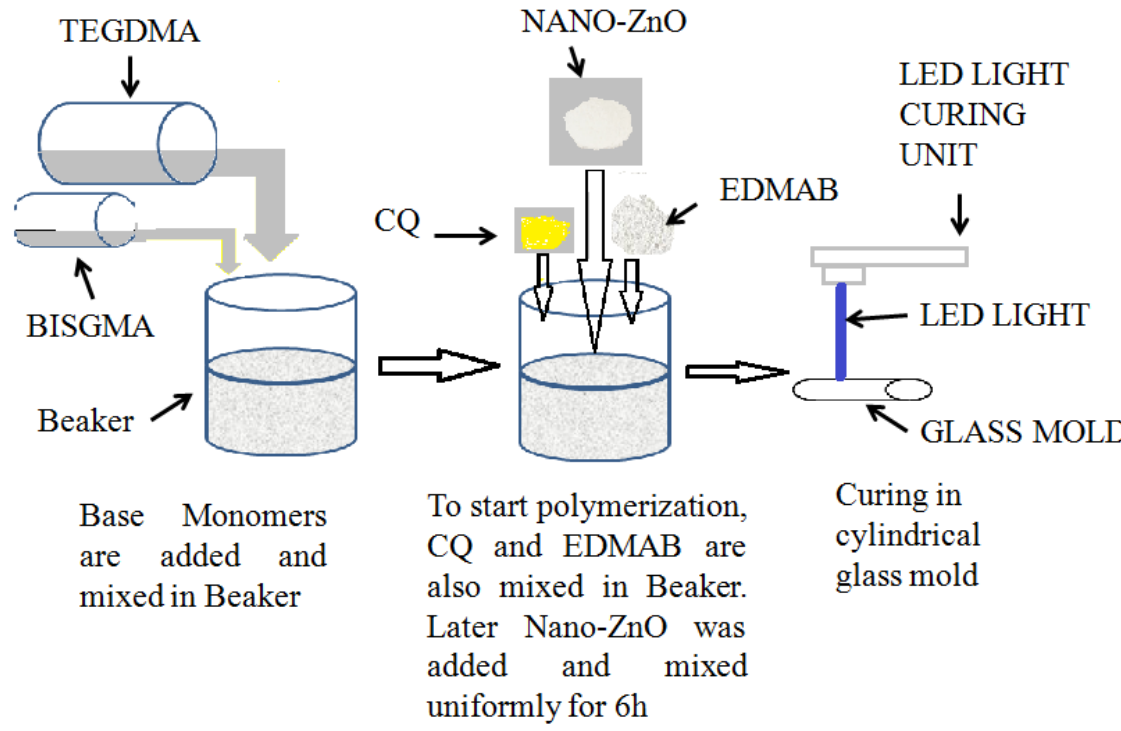
Figure 1: Schematic diagram for the fabrication of dental composite